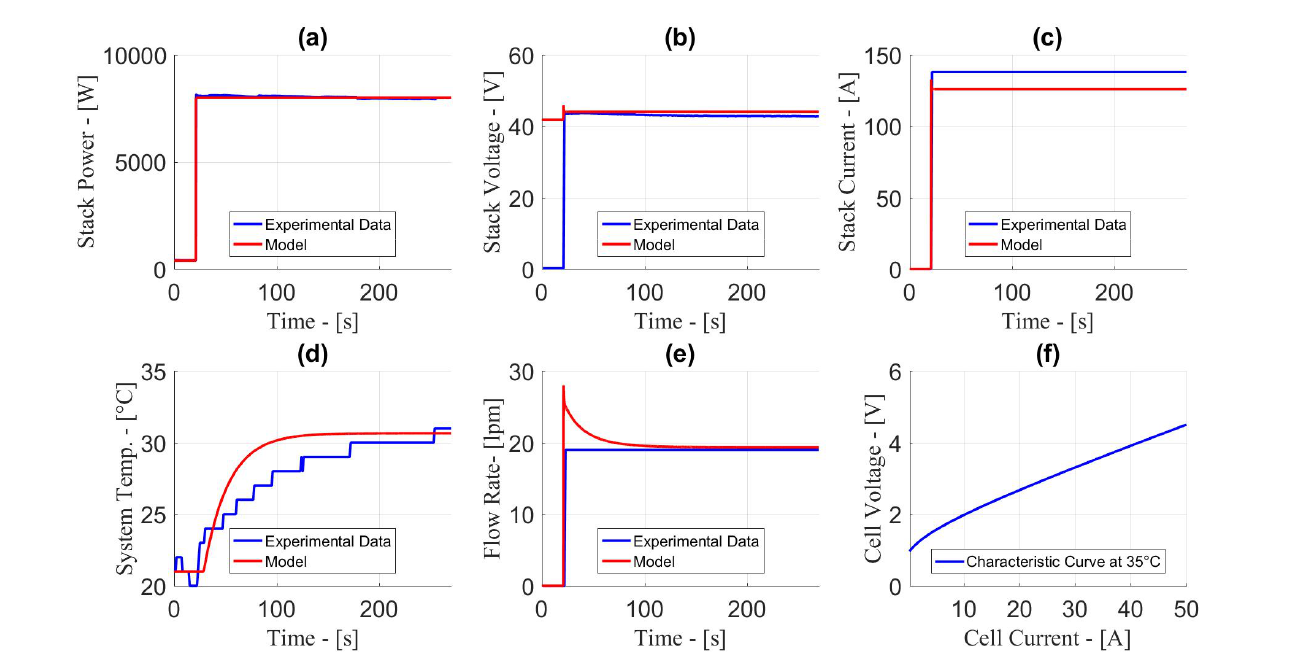
Figure 4. Alkaline electrolyser validation. Input: ( a ) active power in W. Outputs: ( b ) stack voltage in V; maximum error at steady state of 4.58%. ( c ) stack current in A; maximum error at steady state of 6.48%. ( d ) stack temperature in ◦ C; maximum error at steady state of 2.13%. ( e ) flow rate in lpm; maximum error at steady state of 1.89%. ( f ) I-U characteristic curve at 35